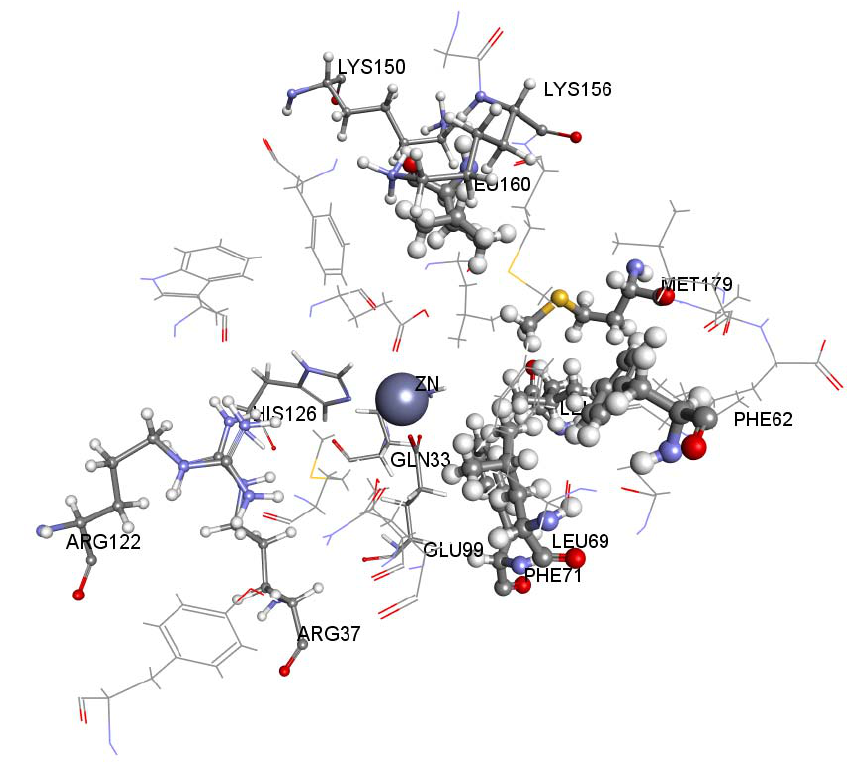
Figure 5. A 3D view representing the three main areas that forms the active site of Glo-1 enzyme. Zn atom is represented by CPK and the hydrophobic pocket and the active site mouth residues are represented by scaled balls and